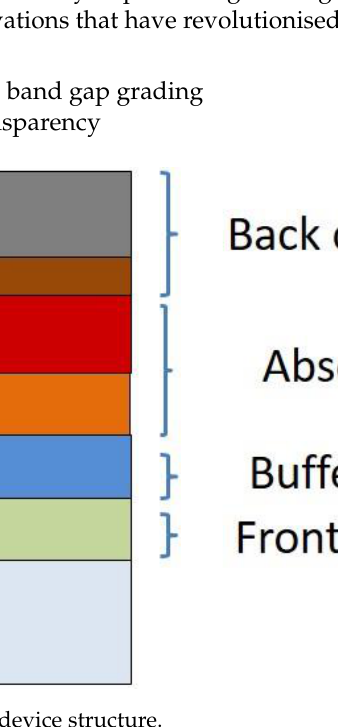
Figure 12. Schema of the more recent CdTe device